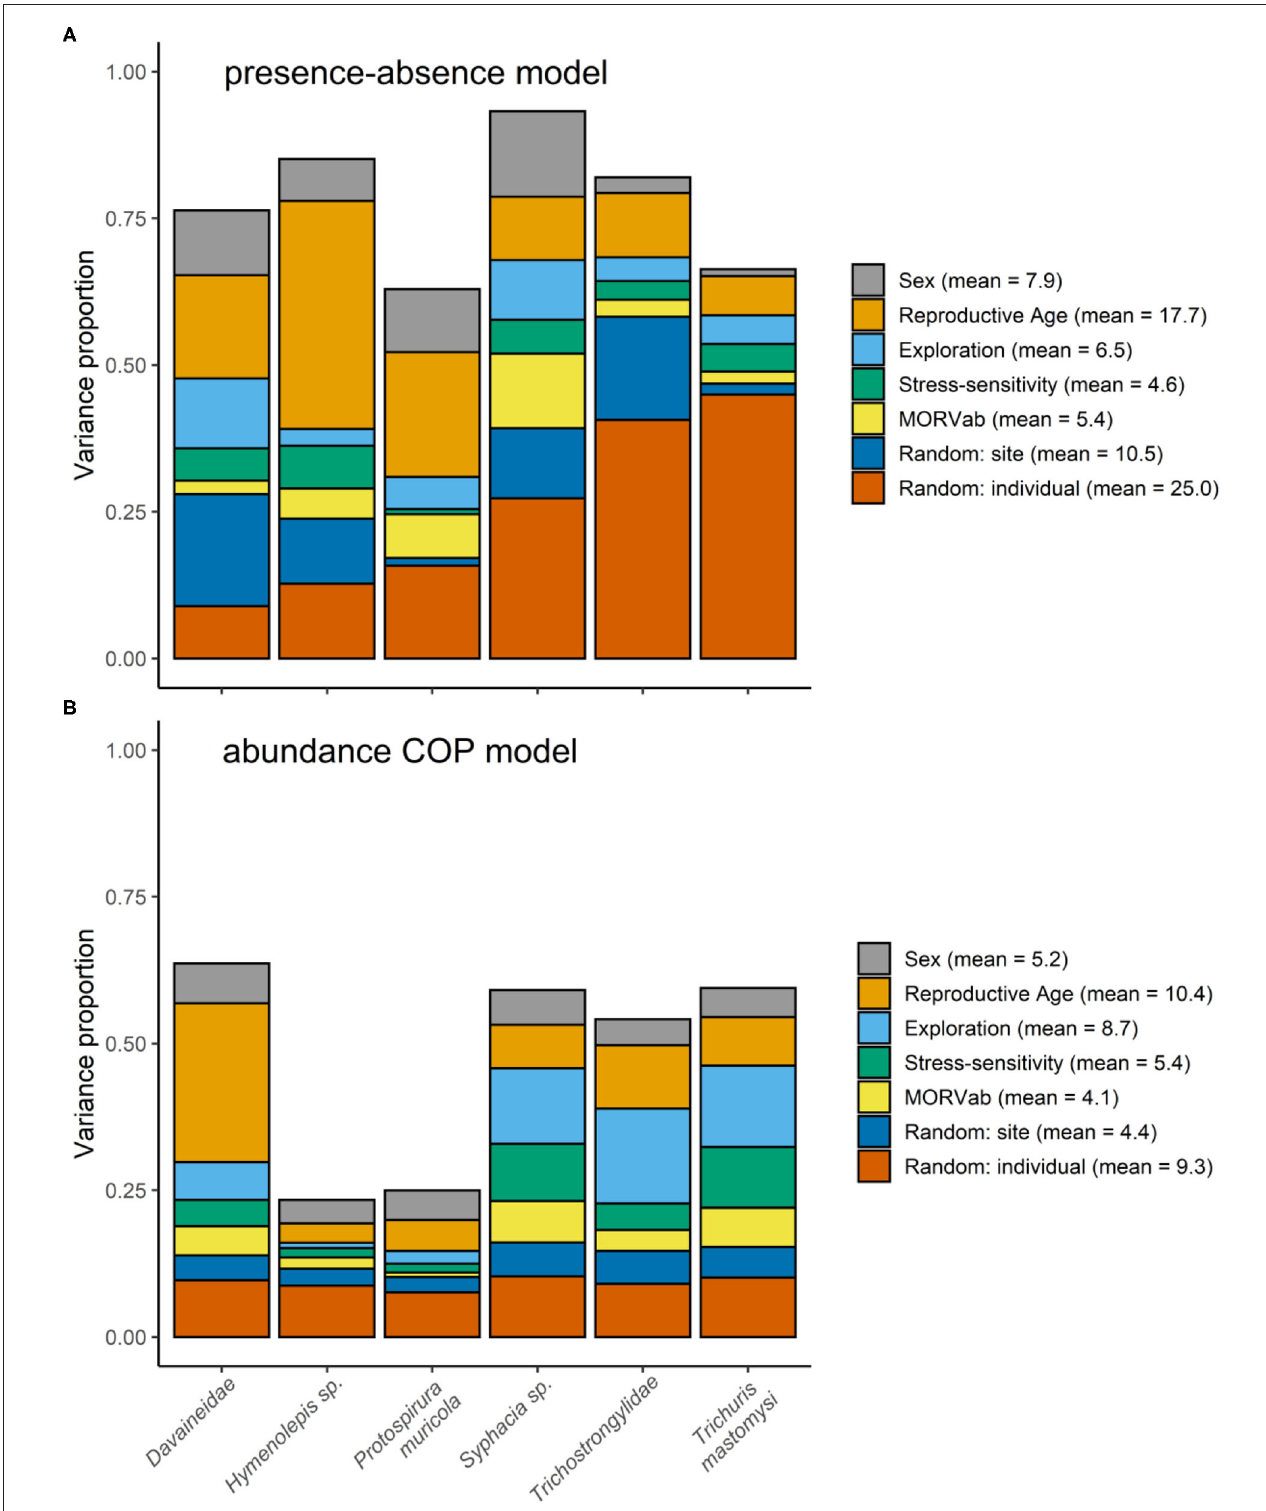
FIGURE 1 | Variance partitioning among the different fixed and random effects from the (A) presence-absence model and (B) abundance COP model. The height of the bars in both panels correspond to the explanatory power achieved by for the different helminth species, measured by the Tjur R ² for the presence-absence model and R ² for the abundance COP model. The legend give the mean variance proportions for each fixed and random effect within the model, averaged over the different helminths.